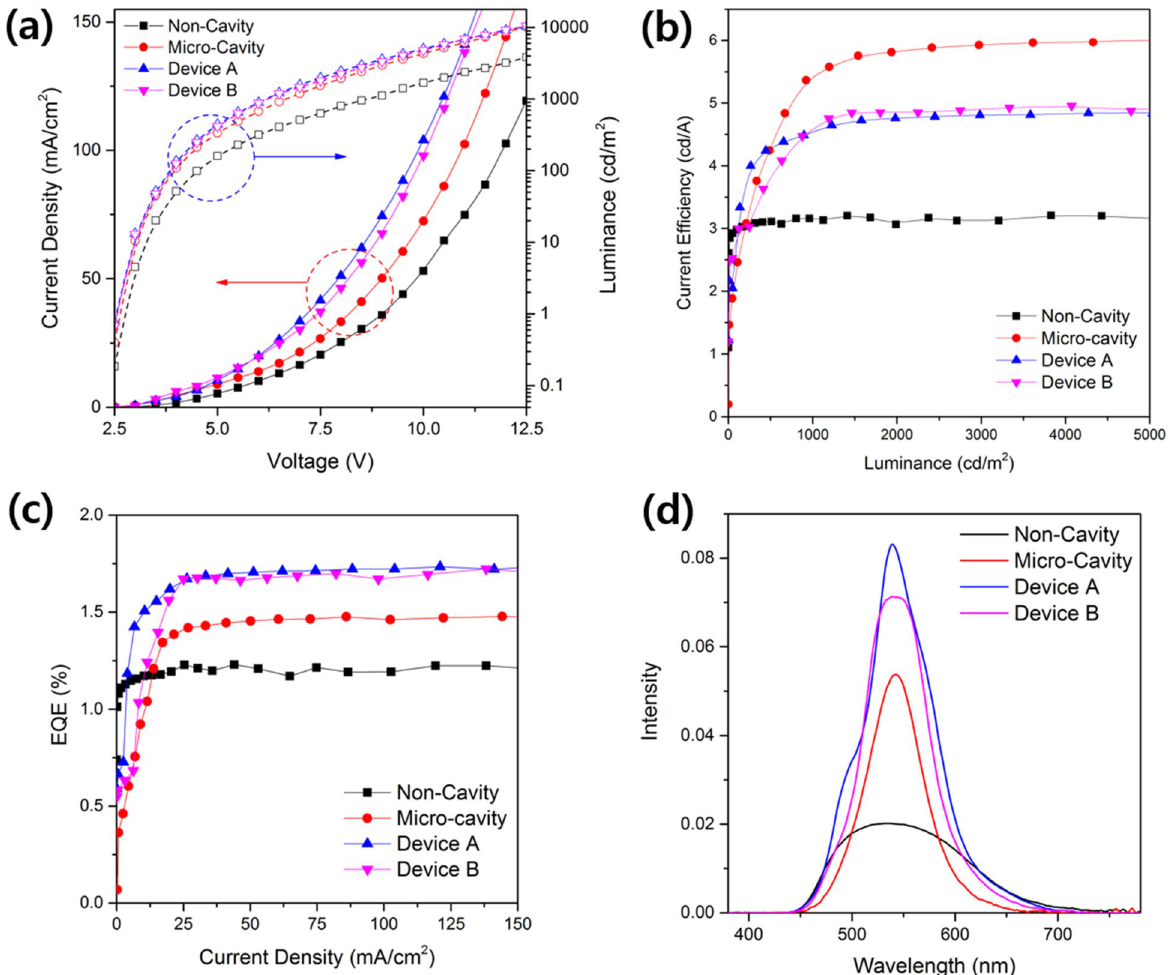
Figure 5. EL characteristics of devices ( a ) current density-voltage-luminance curve, ( b ) current efficiency– luminance curve, ( c ) external quantum efficiency–current density curve, and ( d ) EL spectra of